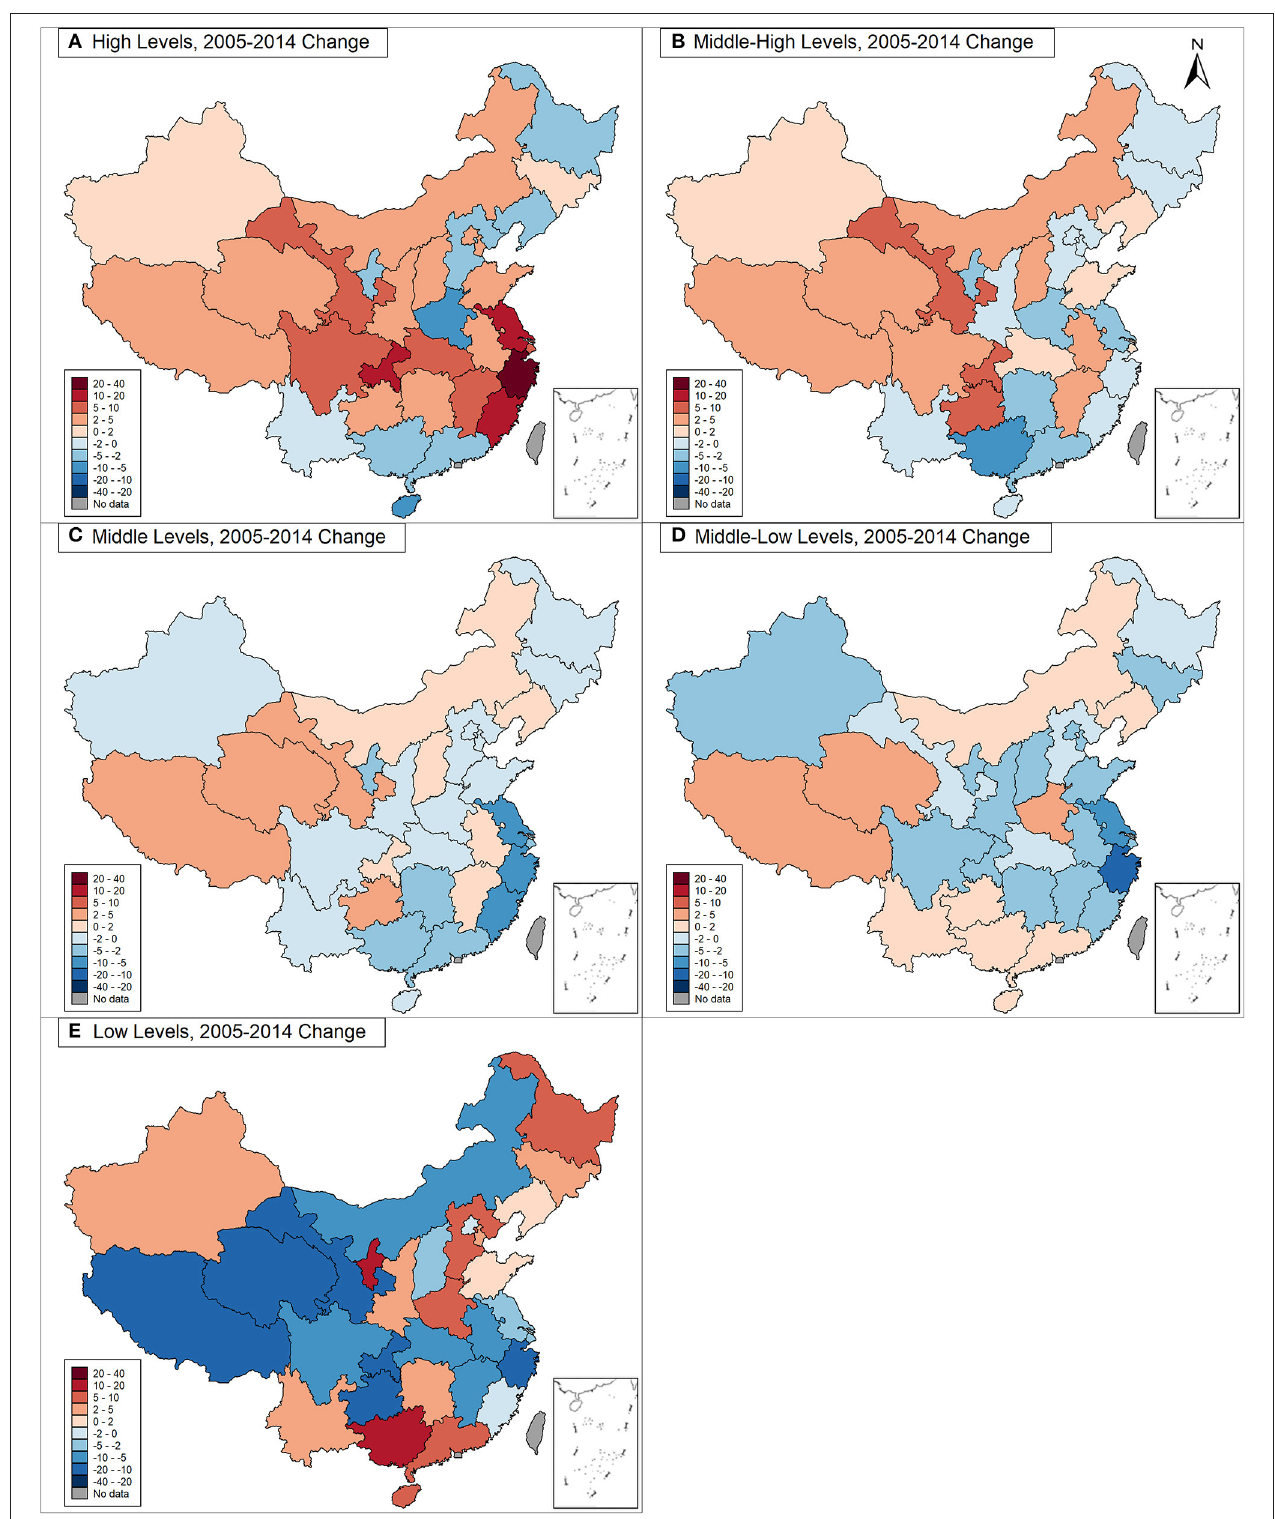
FIGURE 4 | The changes of different levels of physical fitness from 2005 to 2014 (2005–2014, China). (A) For high levels of PFI; (B) for middle-high levels of PFI; (C) for middle levels of PFI; (D) for middle-low levels PFI; (E) for low levels PFI. The red-colored item in subfigure represents an increased percentage point of each level physical fitness index from 2005 to 2014. The blue-colored item in subfigure represents a decreased percentage point of each level physical fitness index from 2005 to 2014. The color gradient of red and blue series was used to show the proportions’ changes of each level of PFI (exact number showed in Supplementary Table 2 ).